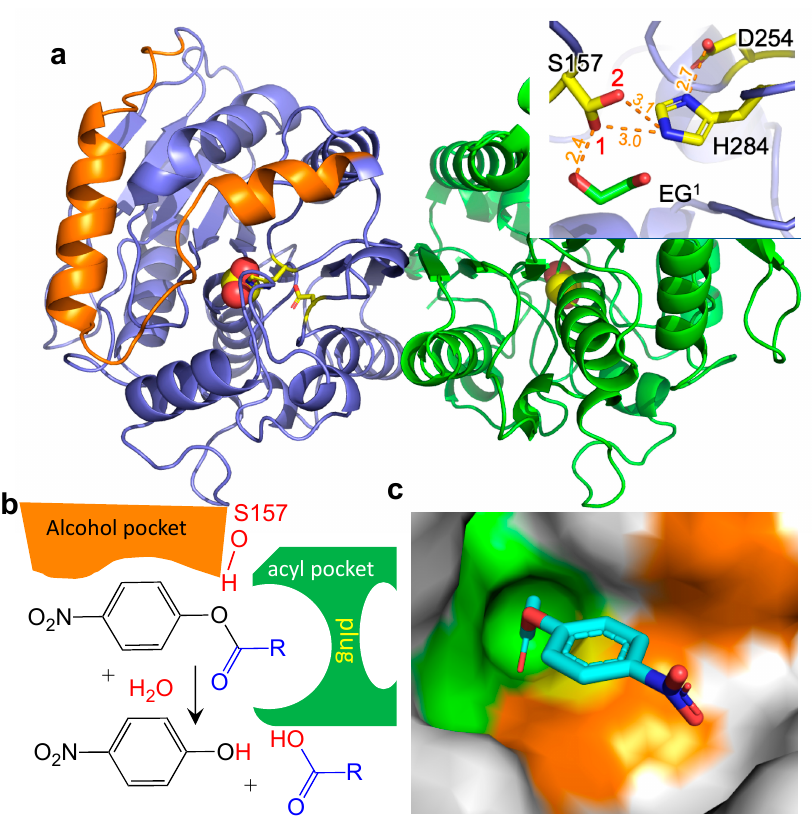
Figure 1. Structure of EstN7 WT . ( a ) Overall dimeric structure of EstN7 (subunit A and B coloured blue and green, respectively) with the catalytic residues coloured yellow, while the N-terminal cap domain is coloured orange. Inset are details of the catalytic site; orange dashed lines represent the distances between individual atoms. EG 1 is an ethylene glycol molecule found in the active site. ( b ) The esterase alcohol and acyl binding pockets, including the acyl pocket plug are shown schematically as are the products of the reaction involving the pNP substrate. ( c ) Substrate binding regions with docked p -NP-C2. The green region represents the acyl binding site (including the plug), orange the alcohol binding site and yellow the catalytic residues.